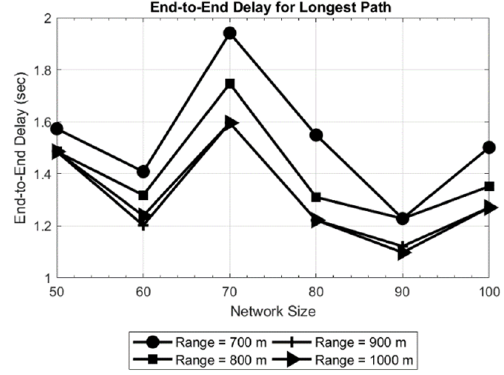
Figure 7. Average delay in network of 2000 × 2000 × 500 m .